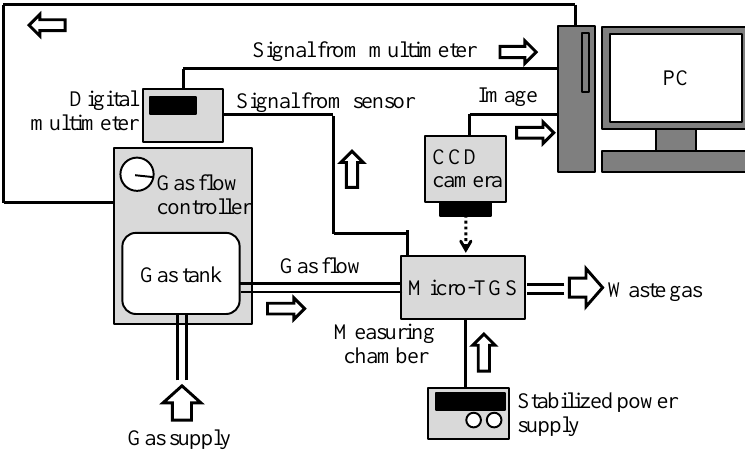
Figure 4. Measurement system of gas sensing properties of micro-TGS.